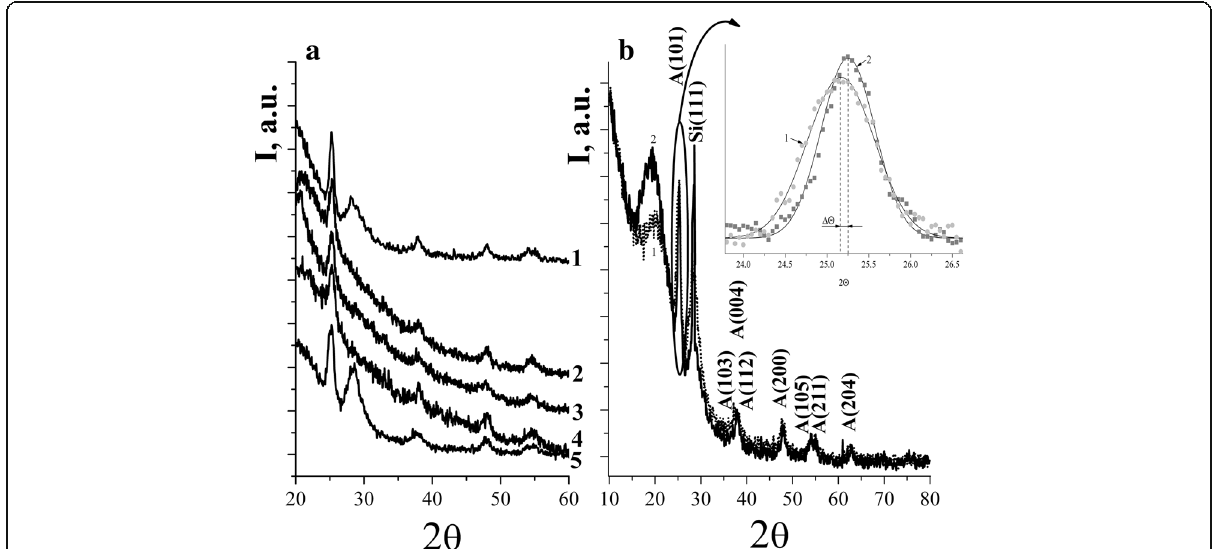
Fig. 1 a XRD pattern of TiO 2 ( 1 ), Co/TiO 2 ( 2 ), Ni/TiO 2 ( 3 ), Mn/TiO 2 ( 4 ), and Cu/TiO 2 ( 5 ) films doped with 5% of metal ions. b XRD patterns of TiO 2 ( 1 ), Cu/TiO